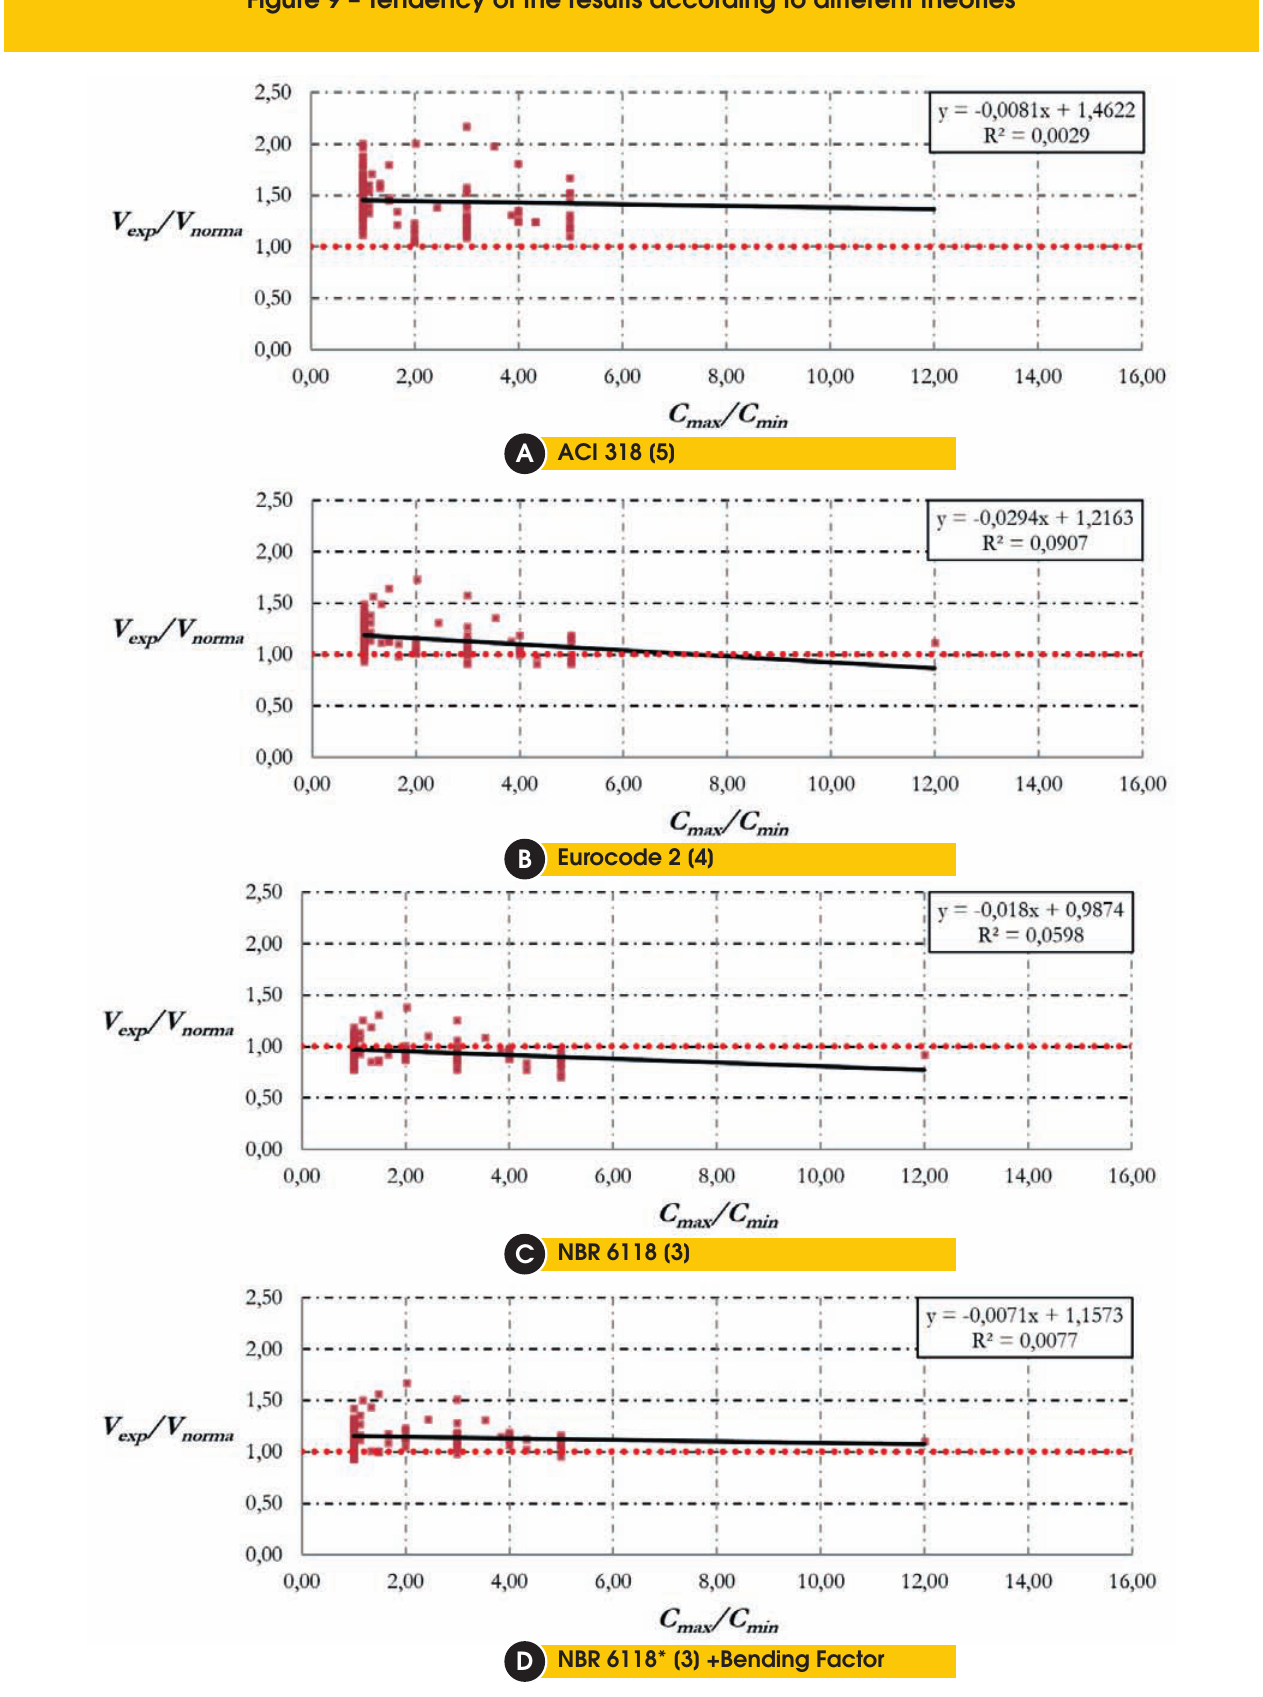
Figure 9 – Tendency of the results according to different